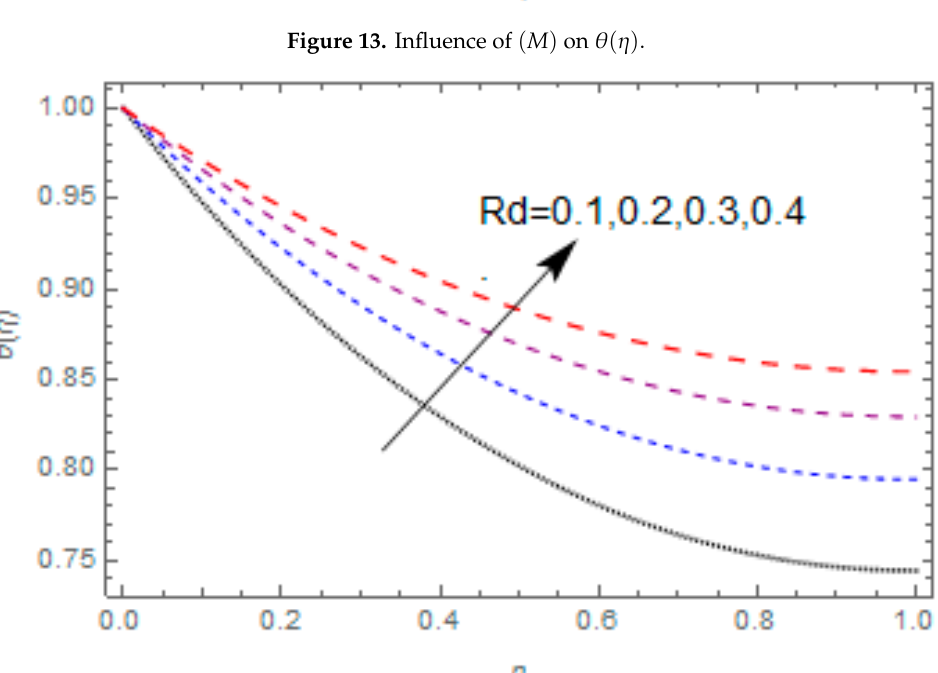
Figure 14. Influence of ( Rd ) on θ ( η )